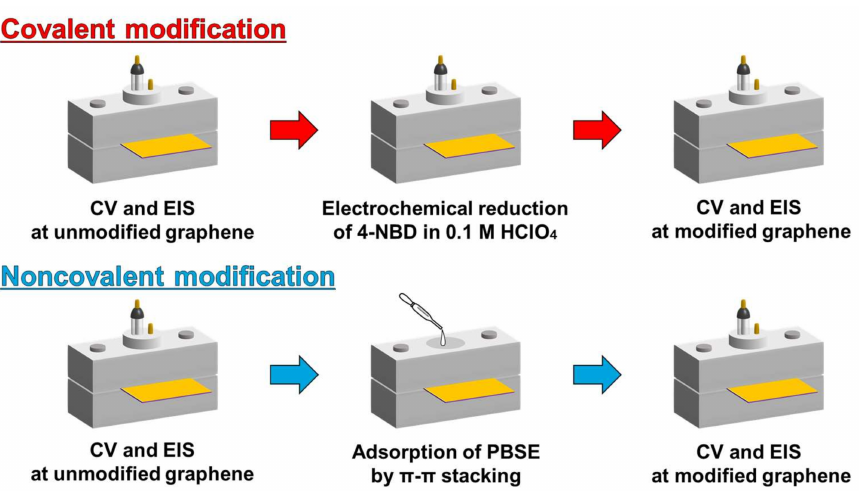
Figure 3. The measurement and modification schemes for evaluating influences of the covalent and noncovalent modifications on electrochemical properties of the graphene electrodes. The graphene electrodes were not dismounted form the cells in the whole